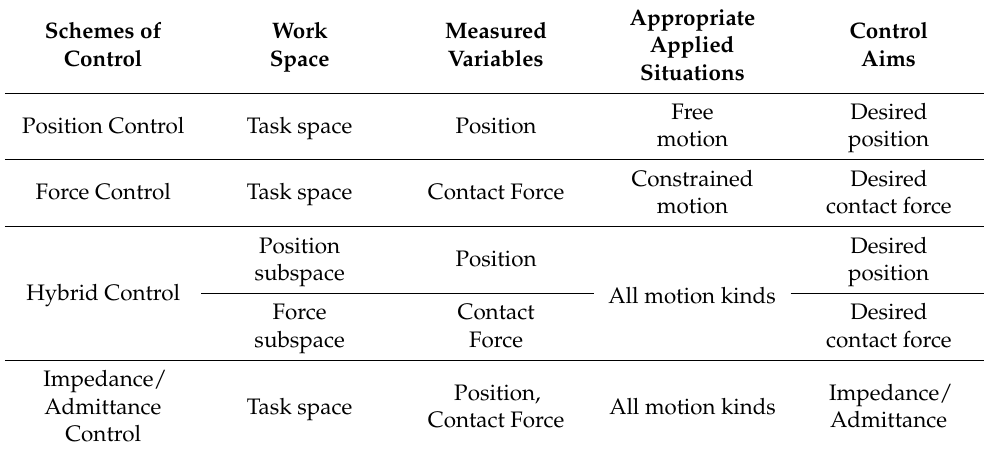
Table 2. Comparison between the different schemes of control. This comparison is done based on ref.